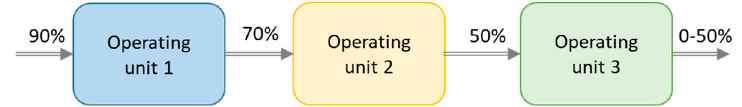
Figure 6. Q concept shows the heat output for a 100 m 2 house with minimum ventilation and ∆ M / M (g / g sample ) stand for the mass increase compared to the initial mass (as dehydrated) of the sample. Energies 2020 , 13 , x FOR PEER REVIEW